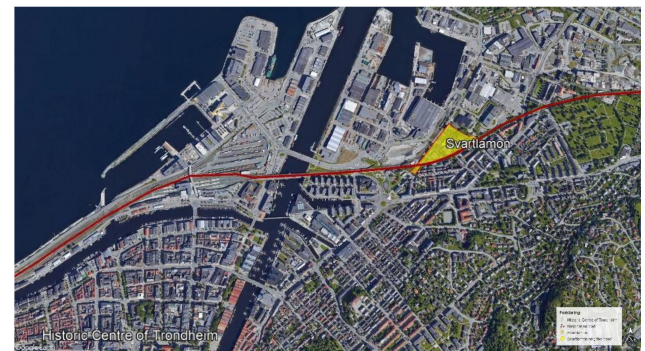
Figure 1. Trondheim Historic Centre, Svartlamon, and National Railroad ( © Google 2021, edited by authors).